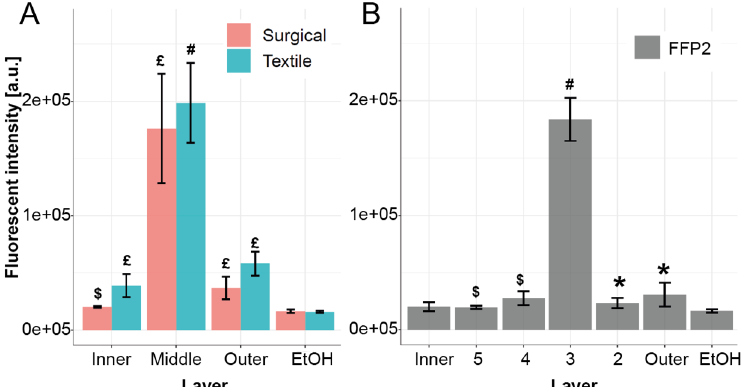
Figure 7. Fluorescent intensity of the different layers of a textile, surgical ( A ) and FFP2 ( B ) mask after filtration efficiency testing with InViS. The air stream flowed from right to left (from outer to inner layer). EtOH control is the fluorescence value of the ethanol solution only. Results represent the mean and corresponding standard deviations from three independent experiments with two technical replicates. *p < 0.05, $ p < 0.01, £ p < 0.001 and # p < 0.0001 compared to